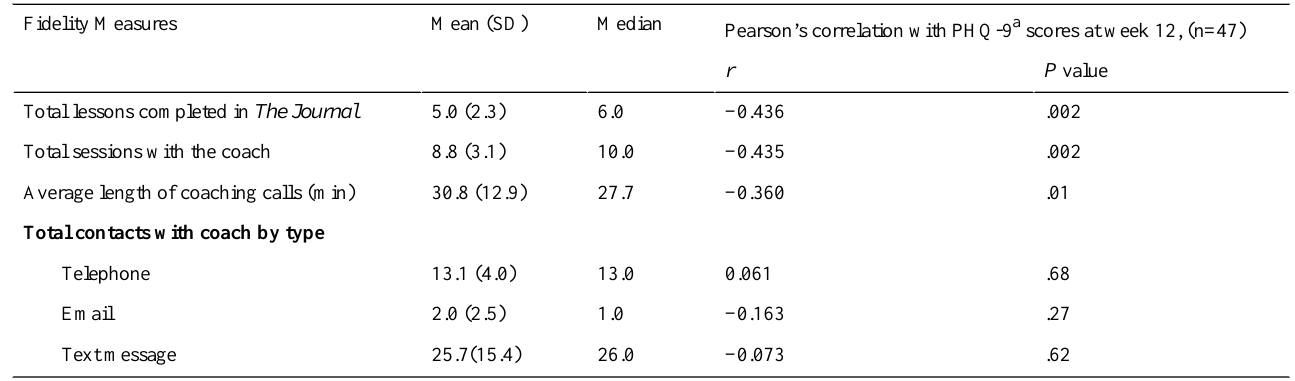
Table 9. Relationship between fidelity measures and Patient-Health Questionnaire scores at 12 weeks